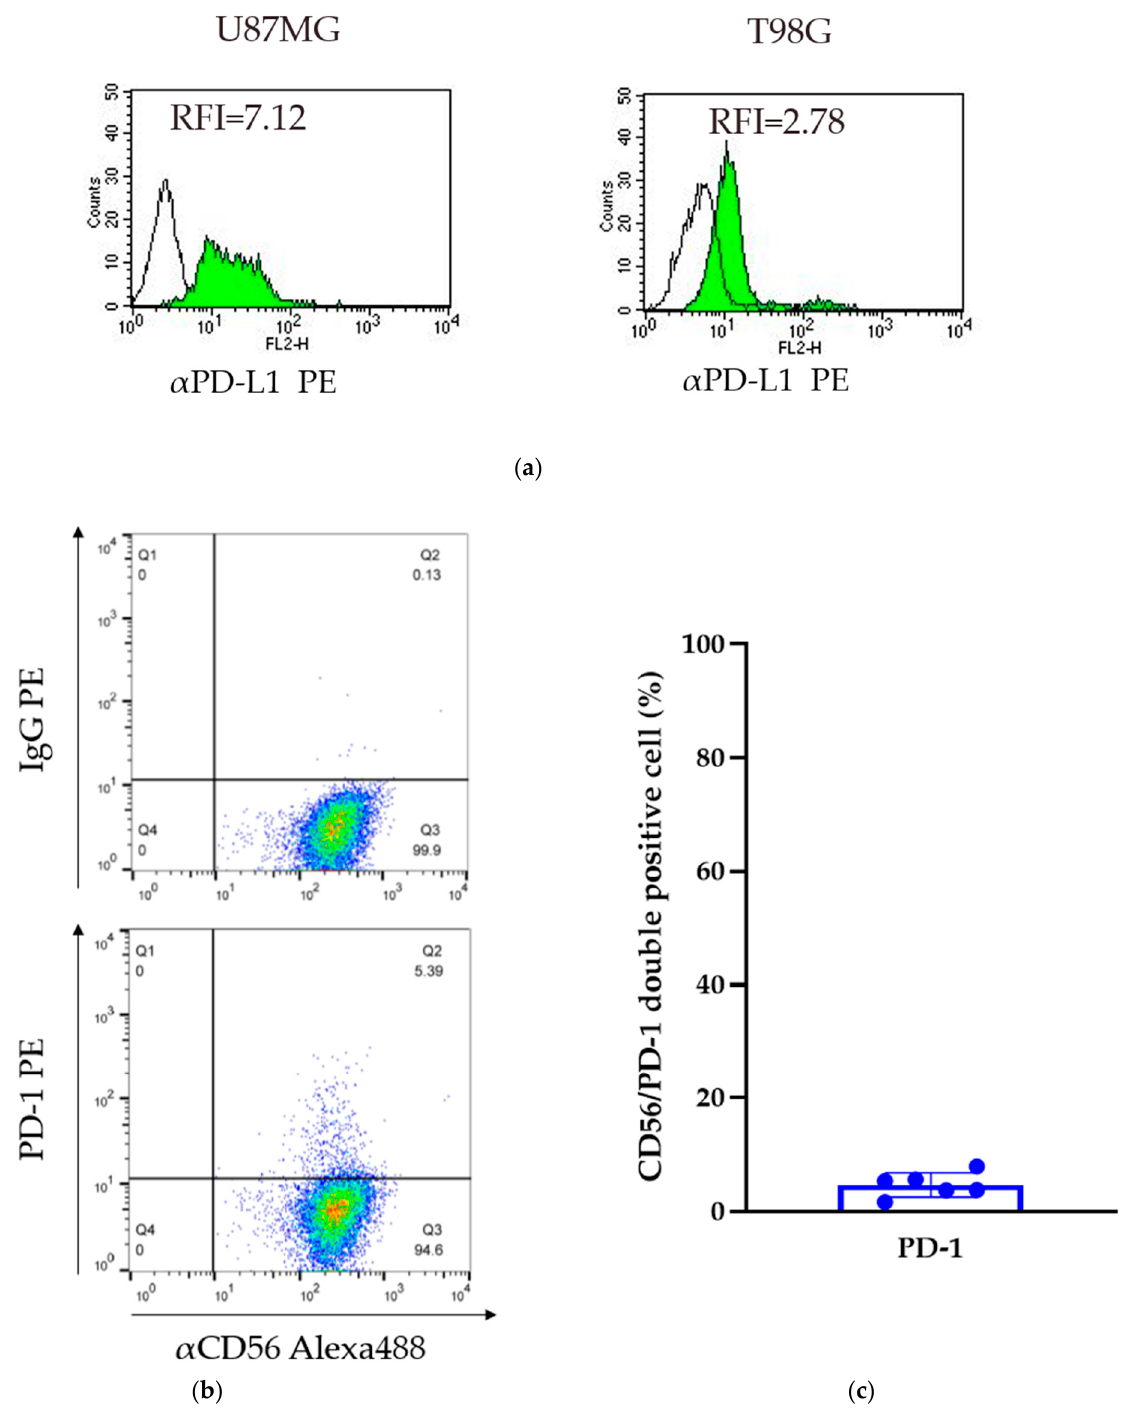
Figure 2. Expression of PD-L1 in GBM cell lines and PD-1 on GiNKs. ( a ) The relative Figure 1 was calculated based on the fluorescent intensity of PE-conjugated PD-L1 antibodies divided by the fluorescent intensity of PE-conjugated IgG. Left: U87MG cells and right: T98G cells. ( b ) The expression of PD-1 on the surface of GiNKs harvested from three healthy volunteers was detected. ( c ) The frequency of PD-1+/CD56+ NK cells of at least two independent experiments ( n = 6).